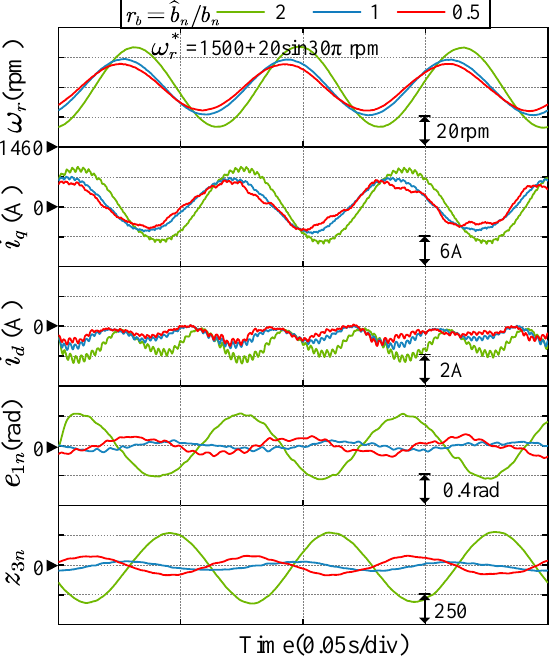
Figure 17. Experimental results of the speed response with sinusoidal speed reference under different r b , where ω 0 n = 120 π , k n = 80 π , r b = [ 0.5, 1, 2 ] . Figure 18 shows the experimental results of the speed response with step load distur- bance. Three groups of experiment results with different r b are presented and compared, where ω 0 n = 120 π , k n = 10 π , r b = [ 0.5, 1, 2 ] . It can be seen that the speed